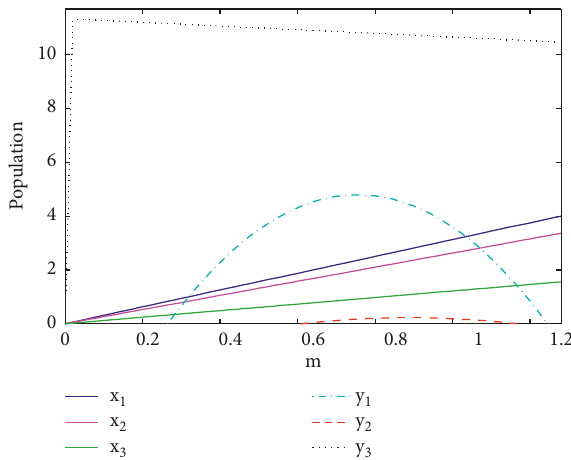
on the system (1). 1